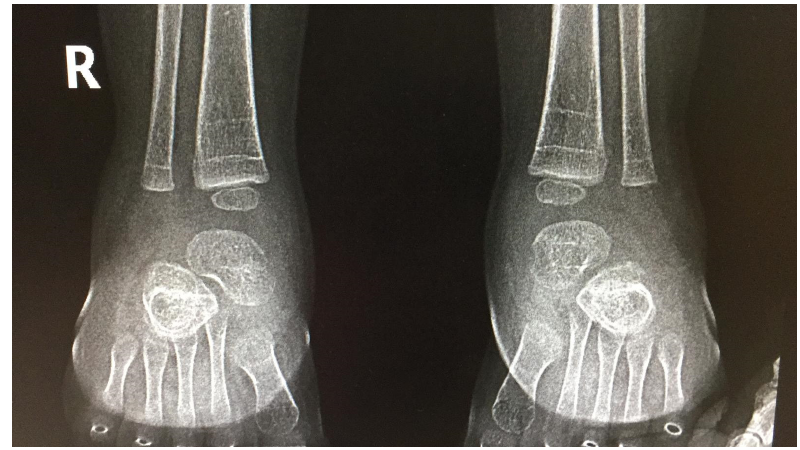
Figure 1. Bilateral foot X-ray (antero-posterior view)—demineralization fractures. Table 2. Clinical and demographic information of control group